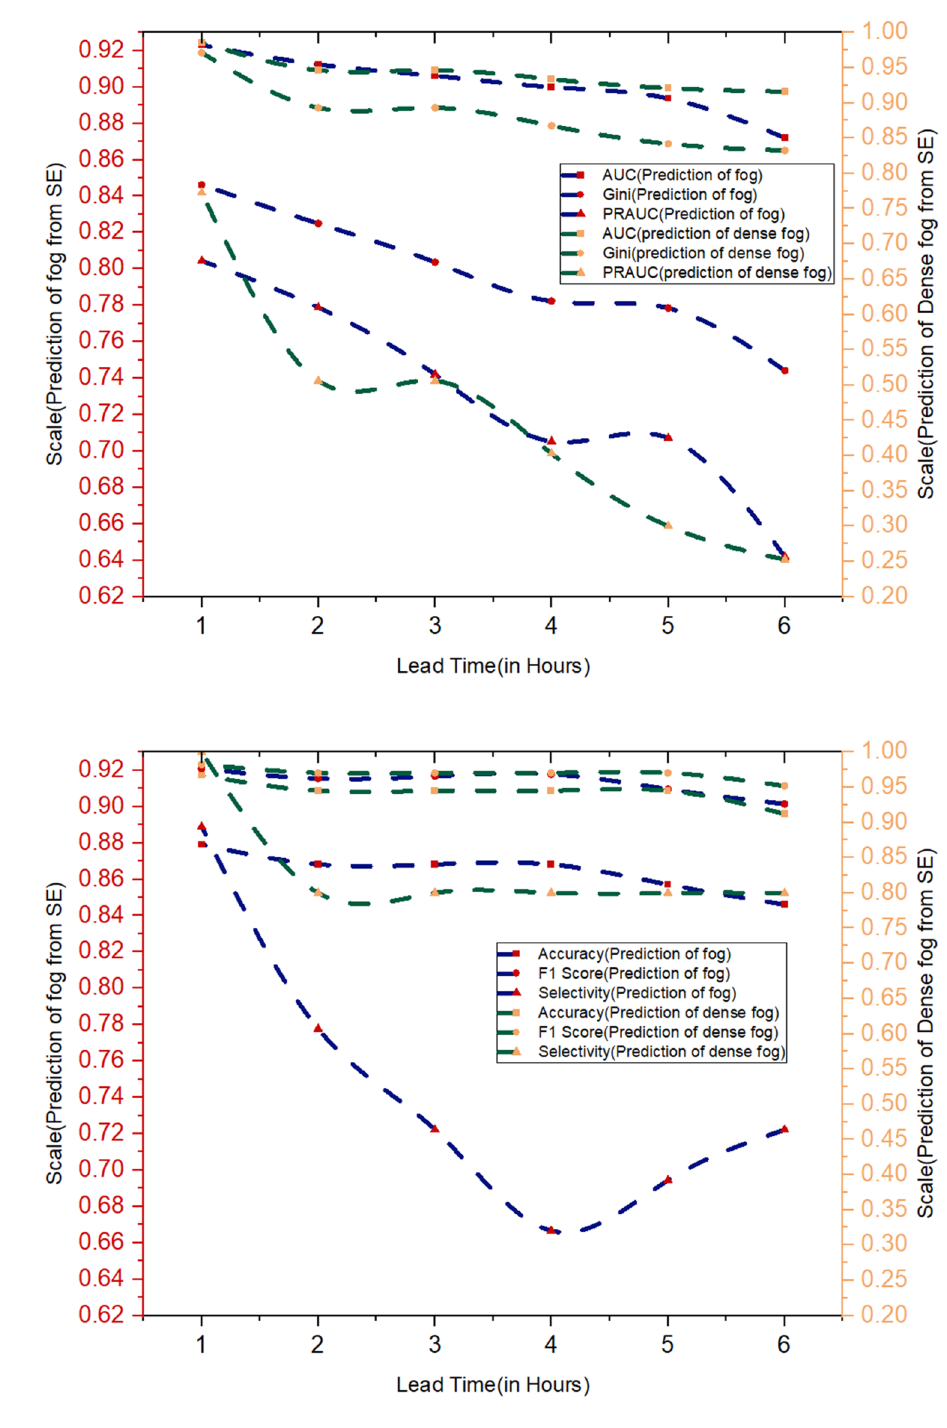
Fig. 7 The performance metric of the proposed machine learning algorithms for the prediction of fog (surface vis- ibility ≤ 1000 m) and dense fog ((surface visibility ≤ 200 m) for